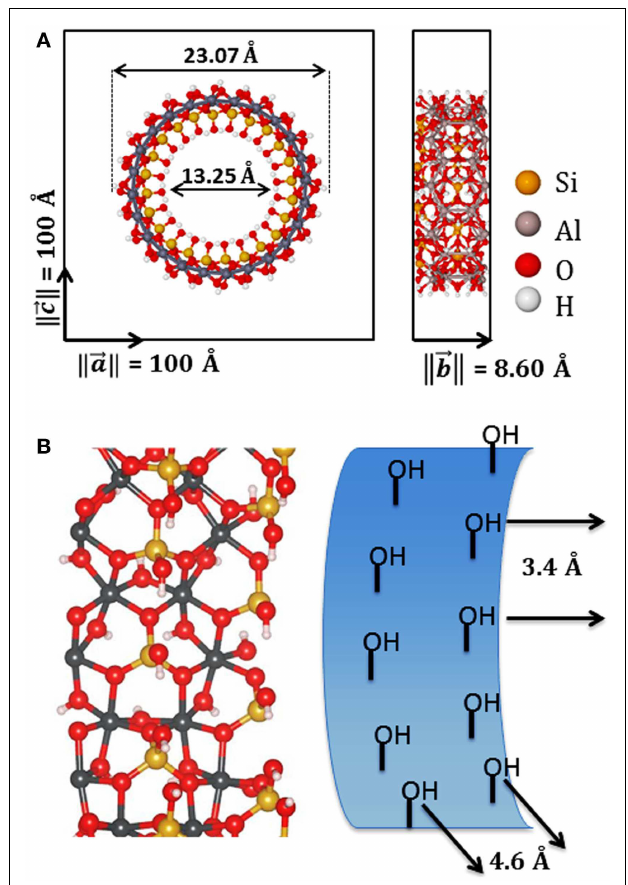
FIGURE 1 | (A) Front and side view of zigzag imogolite (12,0) nanotube unit cell and its lattice parameters; (B) inner surface hydroxyl orientation and main distances between radial and axial inner